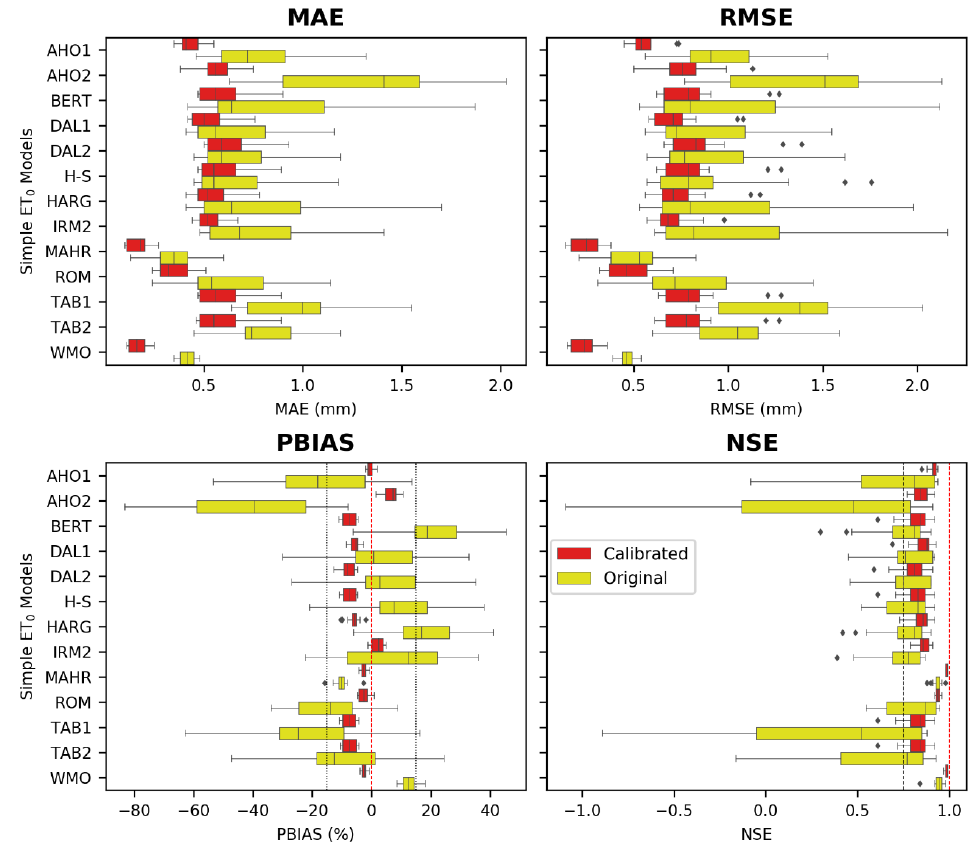
Figure 7. Model performance before (original) and after calibration (calibrated) on a monthly timescale over the period 1960–1999. The models are assessed through the MAE , RMSE , PBIAS and NSE .